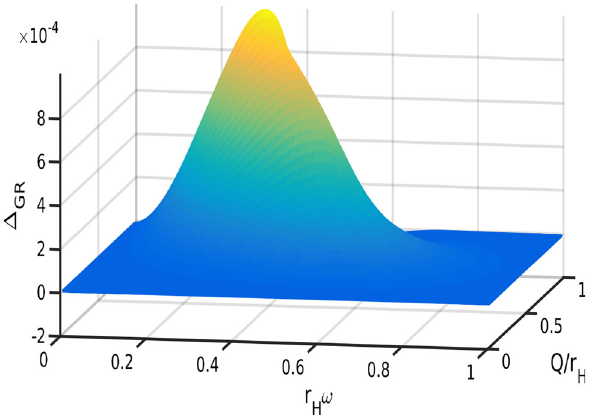
Fig. 2 Relative energy flux difference between scalar and vector emis- sions as a function of scaled charge q and dimensionless frequency ˜